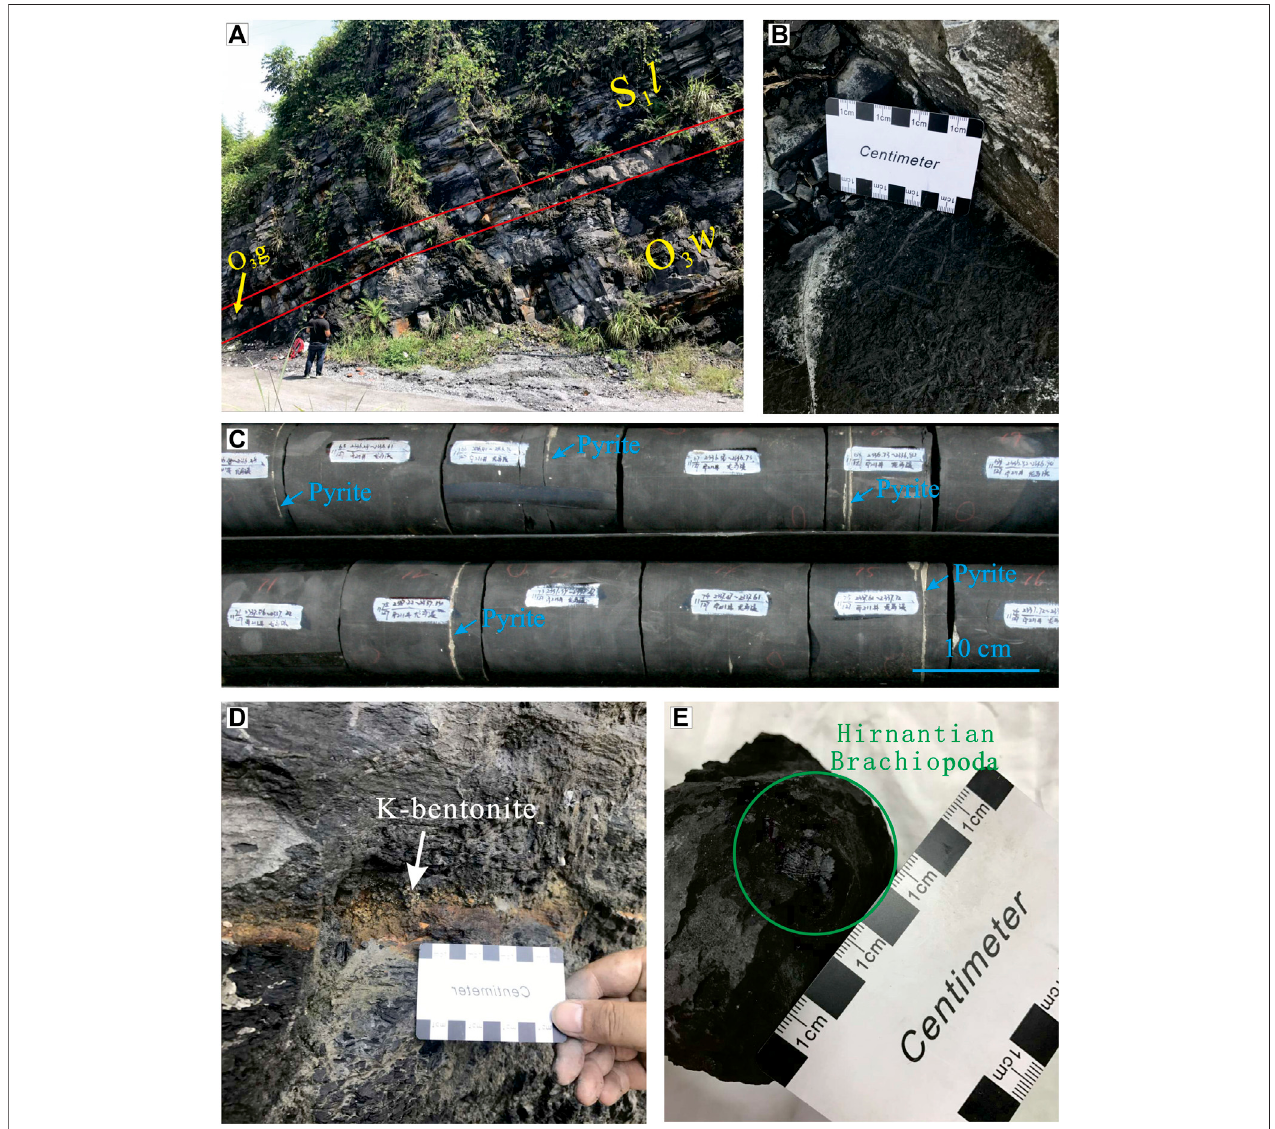
FIGURE2| Stratigraphic characteristics ofthe Wufeng – Longmaxi Formation, Upper Yangtze Region. (A) Continuousblack siliceous shale deposits inthe Wufeng Formation (O 3 w ) and Longmaxi Formation (S 1 l ); the Guanyinqiao Member (O 3 g ) at the top of the Wufeng Formation is approximately 1 m thick. (B) Graptolite-rich siliceous shales in the Wufeng Formation; graptolites are between 0.5 and 5 cm in length. (C) The black siliceous shale of the Longmaxi Formation contains multiple layers of pyrite with a thickness of a single layer less than 3 mm. (D) Potash bentonite intercalation with a thickness of less than 1 cm in the Wufeng Formation. (E) Hirnantianfossilinthe siliceousshales oftheGuanyinqiaoMember;thefossil isapproximately 2cmindiameter. (A, B,D, E) Images oftheShuanghepro fi le; (C) ,images of the well N211